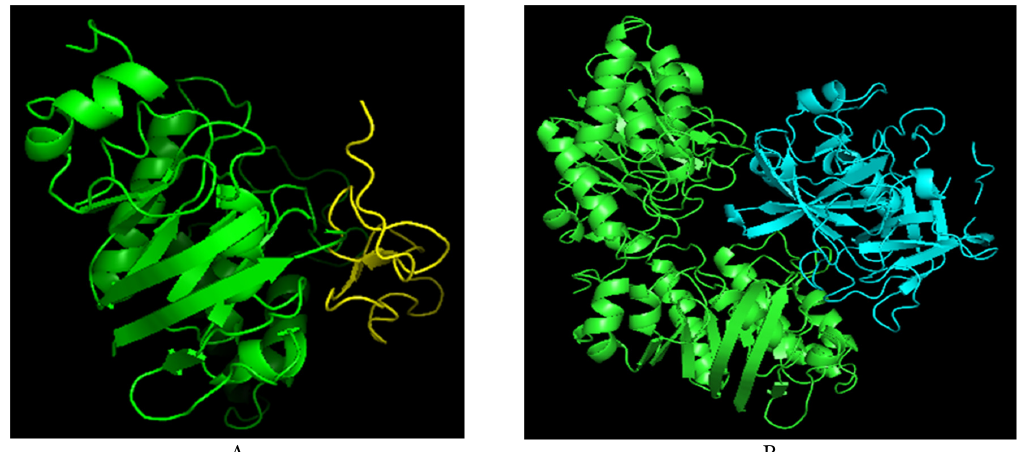
Figure 3. Shigella flexneri lipopolysaccharide protein docking using PyMOL; (A) Shigella flexneri lipopolysaccharide protein with coagulation factor VII (yellow); (B) Shigella flexneri lipopolysaccharide protein with coagulation factor II (cyan)